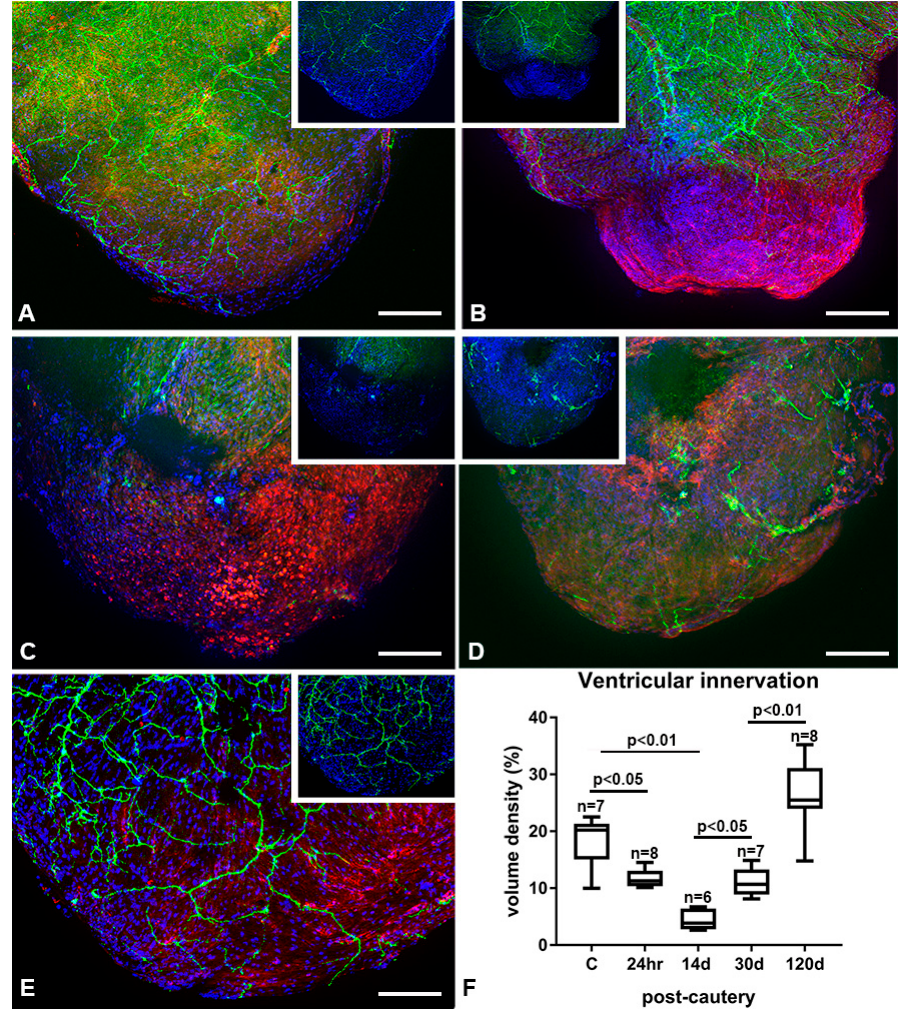
Figure 6. Re-innervation of the regenerating cauterized heart. ( A ) Zn12-stained nerves (green) with wheat germ agglutinin (WGA, red) and Hoechst (blue) in the uninjured ventricle. ( B ) Zn12 immunoreactivity (green) in a ventricle at 24 h post-cautery, showing absence of nerve fibers in the injured apical area. ( C ) Further loss of zn12 staining at 14 days post-cautery (dpc). Zn12 staining at 30 ( D ) and 120 dpc ( E ) in the injured heart. ( F ) Volume density of nerve fibers in the cauterized and regenerating ventricular myocardium. Scale bar = 200 µm.